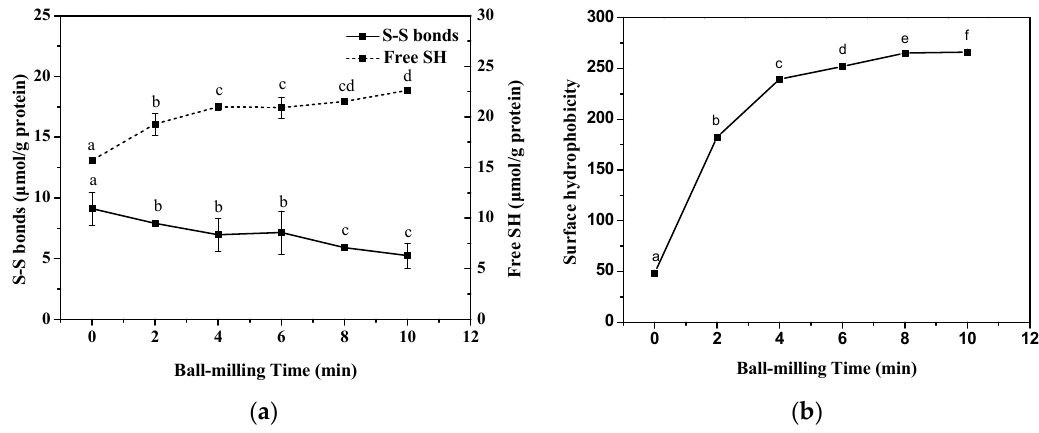
Figure 3. Effects of ball mill treatment (0, 2, 4, 6, 8, and 10 min) on the free sulfhydryl (SH) and disulfide (S-S) bonds ( a ) and surface hydrophobicity ( b ). Different lower case letters denote significantly differences ( p < 0.05).